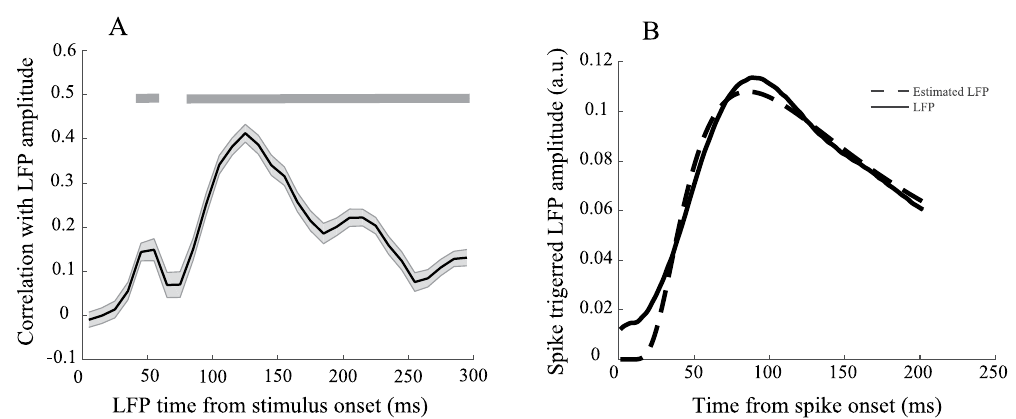
Figure 6. Spike-LFP link in time. ( A ) Correlation of spikes at 55 ms with surrounding LFPs. X-axis shows the times that LFPs come from and Y-axis presents the mean correlation value of spikes at a 10 ms time window around 55 ms with the LFPs. Those times with a significant correlation across recording sites are indicated by a grey bar (corrected for multiple comparisons). Error bars show SEM. ( B ) Spike-triggered LFP for spikes between 0–100 ms after stimulus onset. To show how spikes rule the upcoming LFP, we have averaged the z-scored LFPs following spikes across the recorded sites from both monkeys (solid line). The average spike- triggered LFP is estimated using a Weibull function (shown in dashed line).